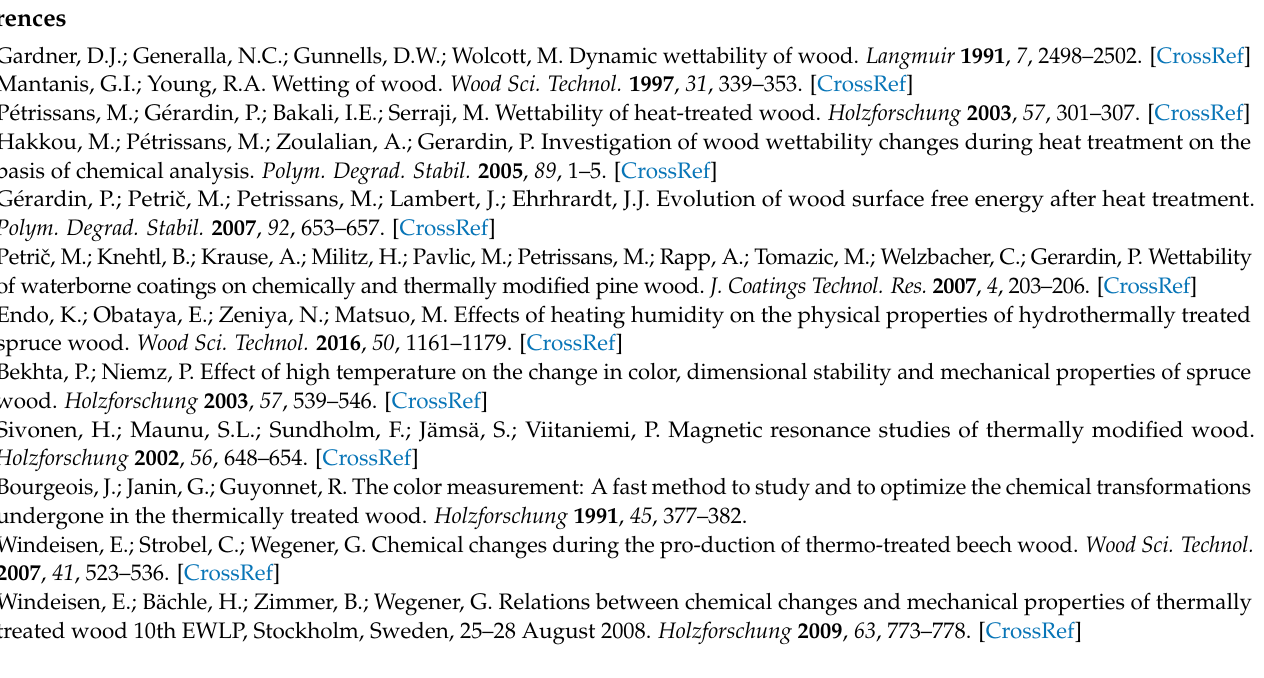
Figure S6: MALDI ToF spectra of heat-treated fir wood at 103 ◦ C in the ( a ) 20–1000 Da